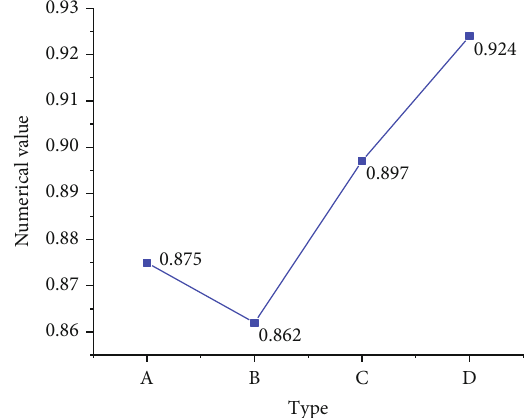
Figure 3: Statistical analysis of Cronbach ’ s α (A: organizational identi fi cation scale; B: employees ’ emotional contagion scale; C: employees ’ mental health scale; and D: employees ’ work enthusiasm